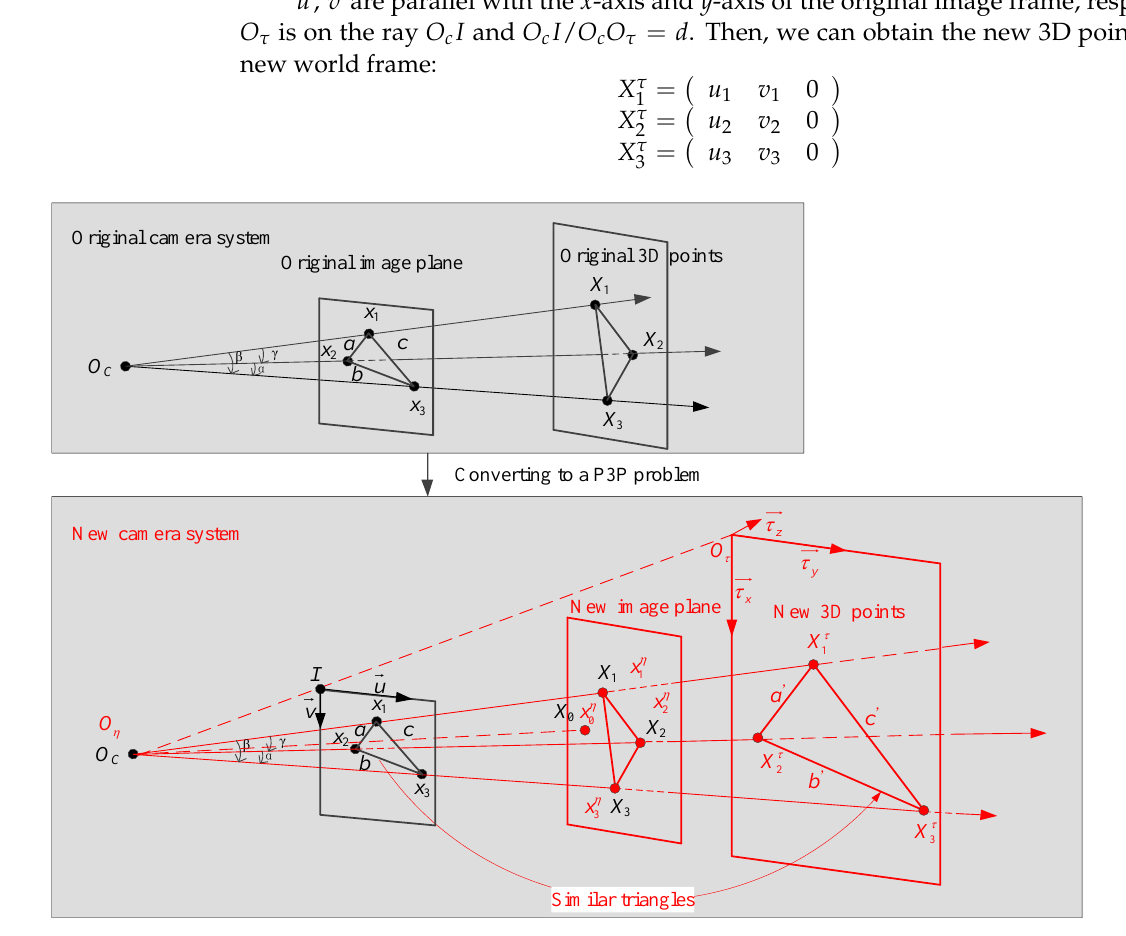
Figure 3. Converting to a P3P problem.